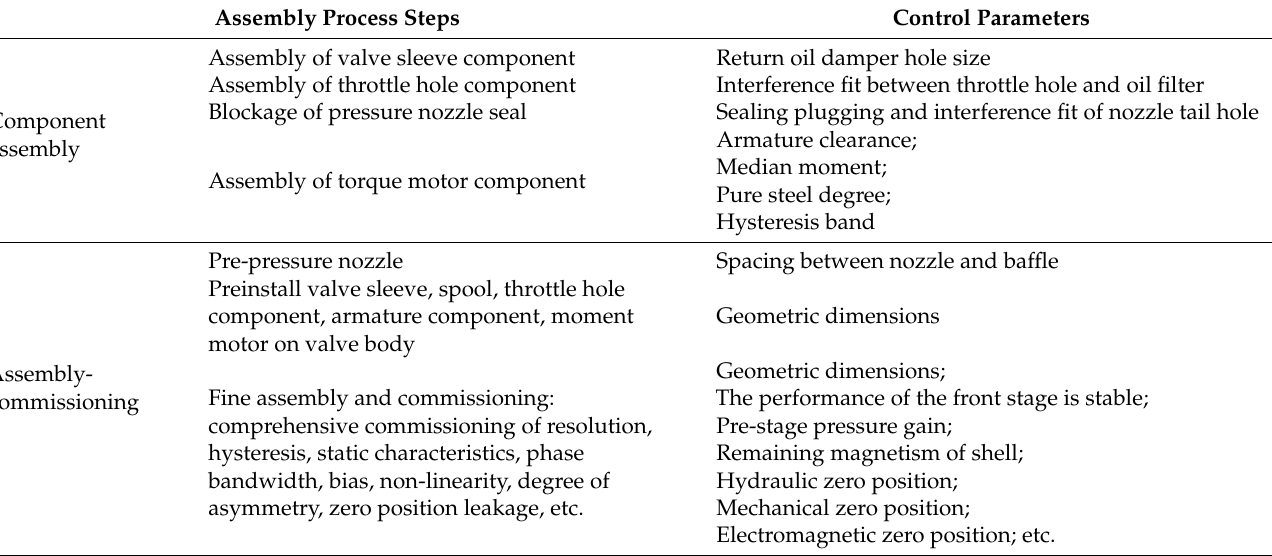
Table 2. Assembly-commissioning process and control